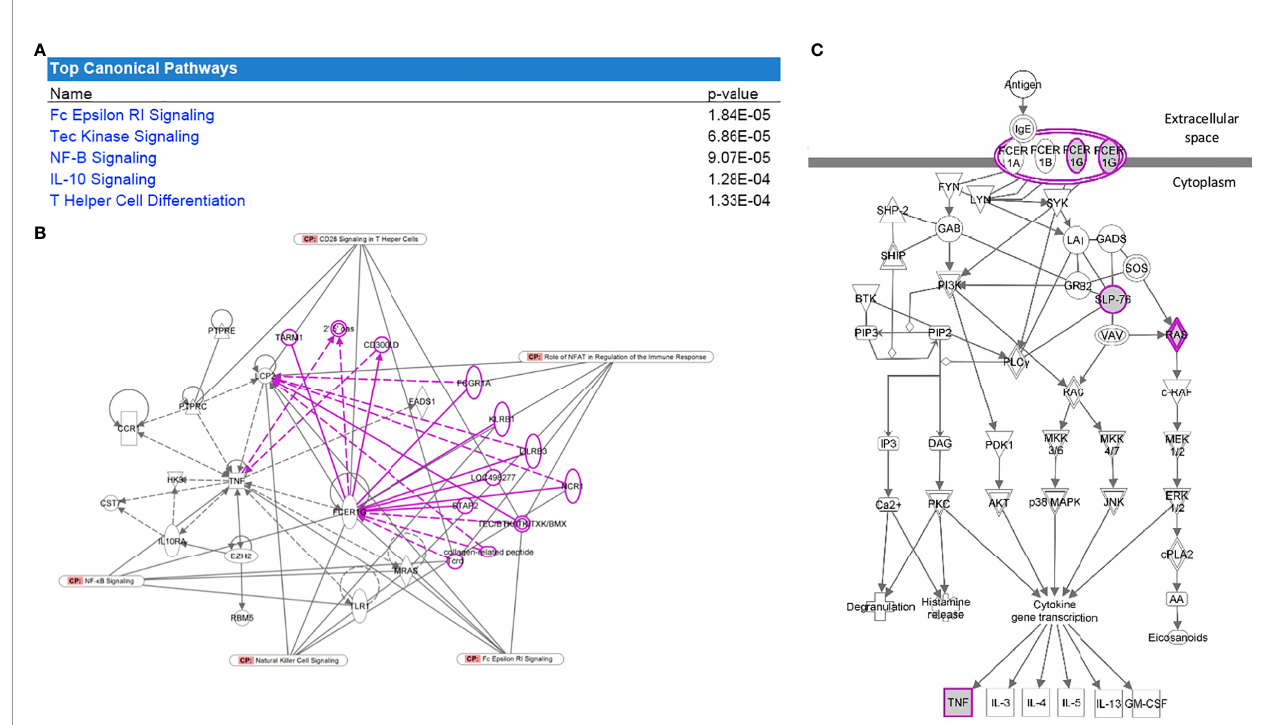
FIGURE 4 | Pathway analysis of the overlapped gene expression that is common in cohorts 1 and 2. (A) Table with the top signi fi cant canonical pathways in the 28 genes were found to be signi fi cant for DKD and overlapping between both datasets. (B) FcER1 signaling was identi fi ed as the center node of the signi fi cantly enriched canonical pathway connecting most of the identi fi ed signi fi cant genes including Tec Kinase, NF-B, IL-10 , and T Helper cell differentiation pathways. Nodes outside the gene-set with known interactions are displayed in pink. (C) It is the known signaling pathway of FcER1, where the proteins including FcER1, TNF, SLP, and Ras are also present in the common 28 genes